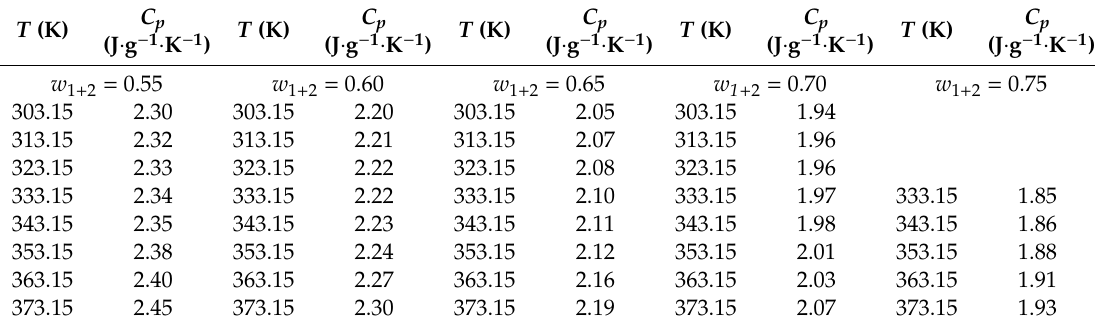
Table A7. Specific heat capacities at absorbent mass fraction w of the system LiBr (1) + [BMIM]Cl (2) + H 2 O (3) at p = 0.1 MPa a .